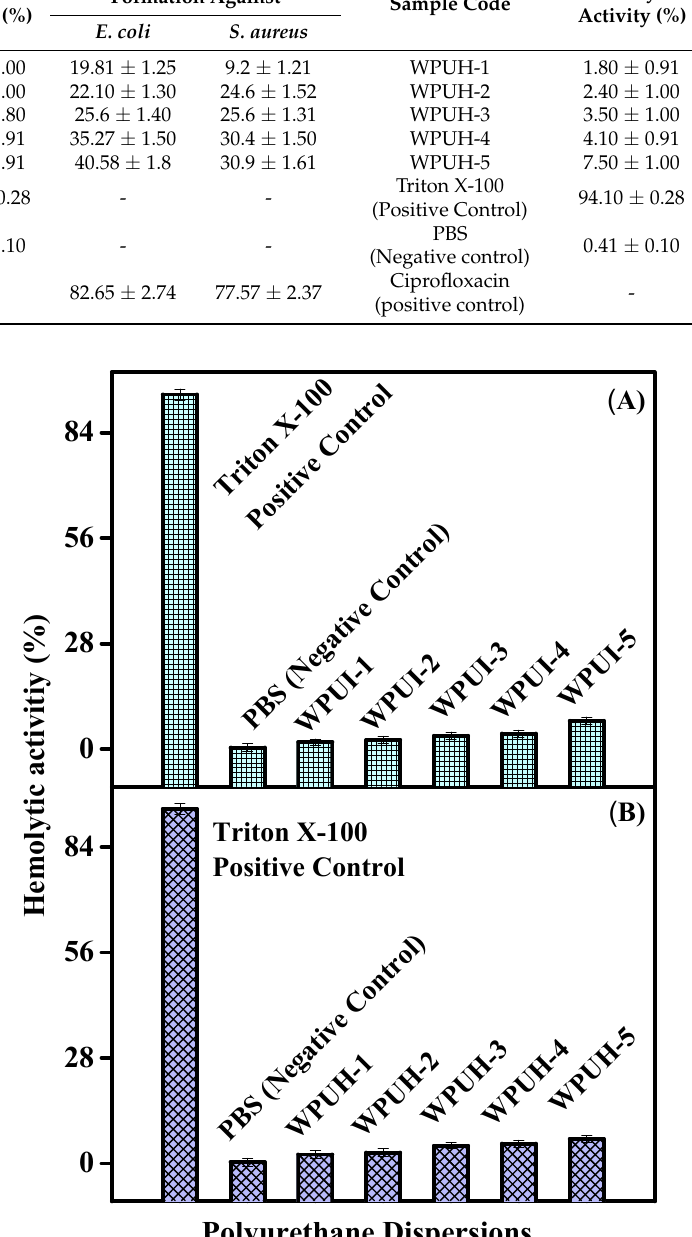
Figure 5. Hemolytic activity of polyurethane dispersions. ( A ) Hemolytic activity of WPUI. ( B ): Hemolytic activity of WPUH series.